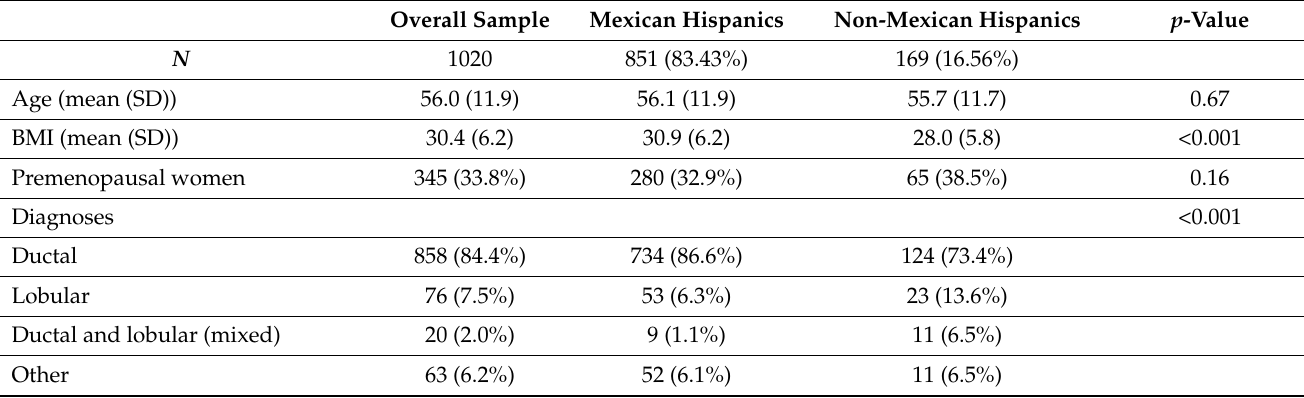
Table 1. Distribution of patient characteristics, overall and by Hispanic